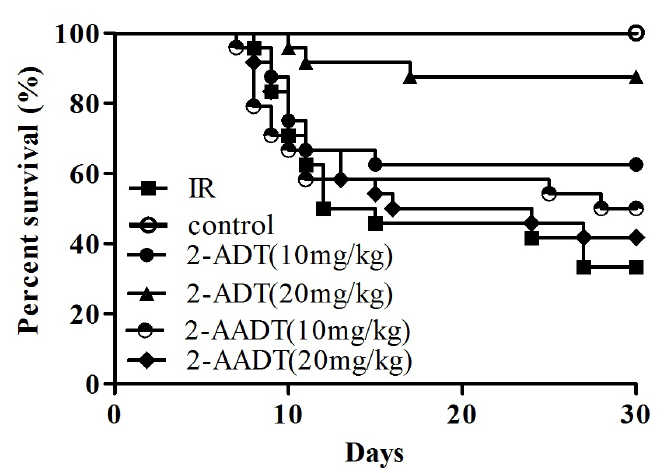
Figure 1. Survival curve of mice exposed to 7.5 Gy WBI. Mice ( n = 24 each) were injected i.p. with 2-ADT or 2-AADT 30 min before being exposed to 7.5 Gy WBI. Comparison of survival curves by Kaplan-Meier survival analysis and the log-rank (Mantel-Cox) test. the difference in survival between the vehicle+IR and 2-ADT 20 mg/kg group was statistically significant ( p <